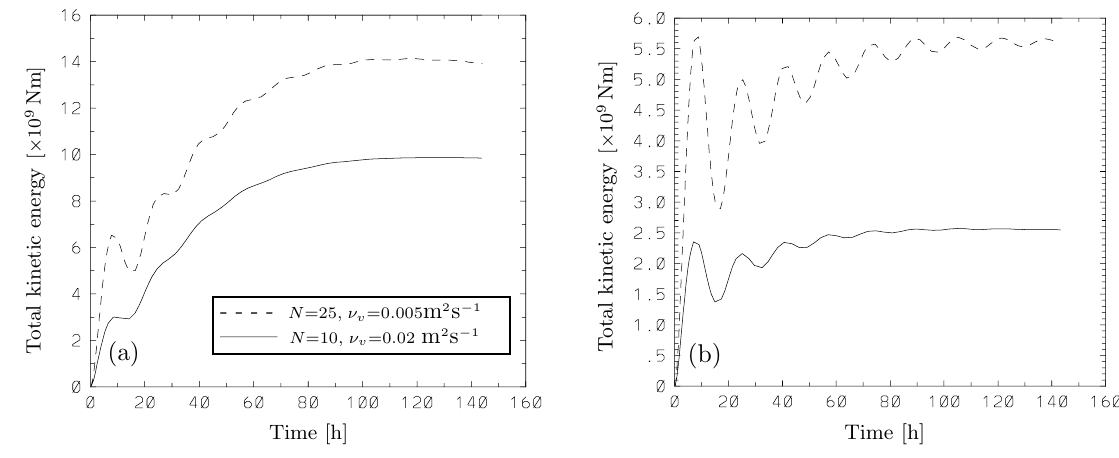
FIG. 14: Time series of the total kinetic energy in Lake Constance subject to constant wind from 305 ◦ NW approximately in the long direction (a) and from 215 ◦ SW approximately in the cross direction (b) with two different values of the vertical eddy viscosity.